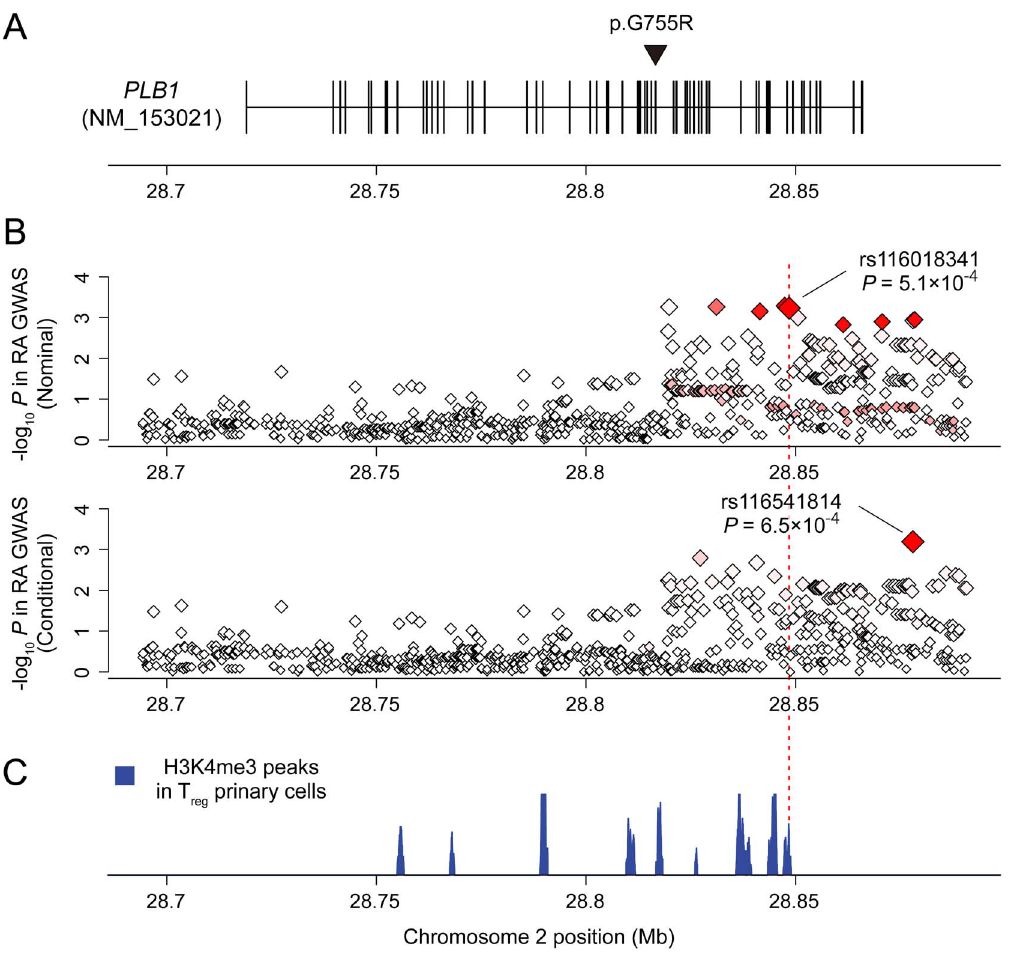
Figure 4. Association of the PLB1 locus in RA GWAS meta-analysis. (A) Coding regions of PLB1 and p.G755R mutation identified in the consanguineous RA pedigree. PLB1 consists of 58 exons (NM_153021), and p.G755R (c.2263G . C) mutation was located at exon 33 (the black triangle). (B) Regional association of PLB1 in RA GWAS meta-analysis including 8,875 RA cases and 29,367 controls from the European populations. Upper panel showed the results of nominal association, and the lower panel showed the results of conditional analysis with rs116018341, the top SNP in the nominal associations. The red diamond-shaped dots represent P-values of the SNPs in the GWAS meta-analysis, and the intensity of the red color in the dots represents the r 2 value with the most significantly associated SNP. Stepwise logistic regression analysis demonstrated multiple independent signals driven by non-coding variants. (C) H3K4me3 peak of T reg primary cells in the PLB1 locus. Non-coding RA risk SNP of rs116018341 overlapped with one of the H3K4me3 peaks as the SNP located in the most vicinity of the peak summit (a vertical dashed red line).